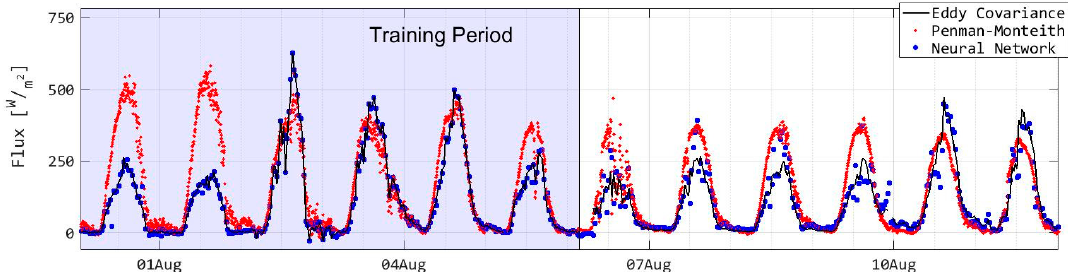
Figure 3. Excerpted time series of latent heat flux determined by the eddy-covariance measurements, Penman-Monteith equation (with no crop coefficient applied) and the actual latent heat flux estimated by the artificial neural network (ANN) method. The shaded area indicates the period used for training the ANN.